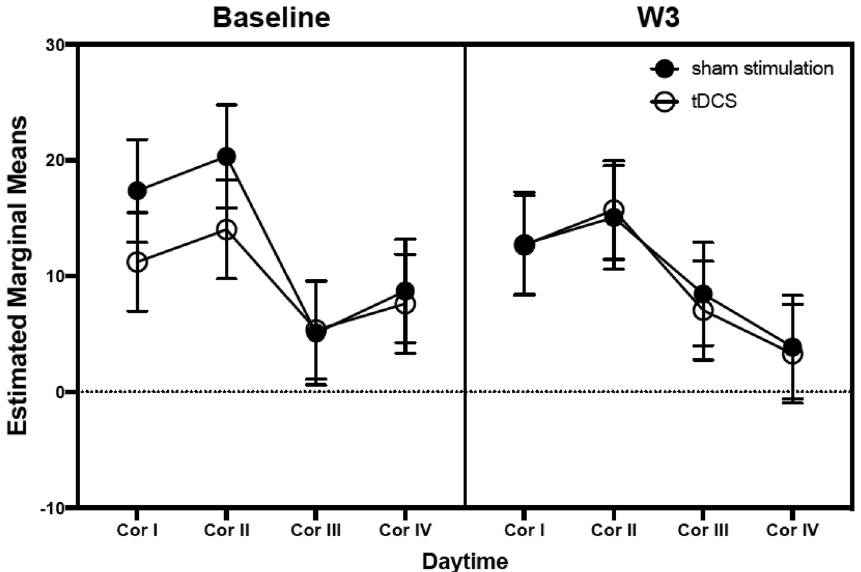
Figure 2. Estimated marginal means of diurnal cortisol profile (nmol/L) for tDCS and sham stimulation groups. Cor I, between 7:30 and 8:00 AM; Cor II, between 8:00 and 8:30 AM; Cor III, between 3:30 and 4:00 PM; Cor IV, between 9:30 and 10:00